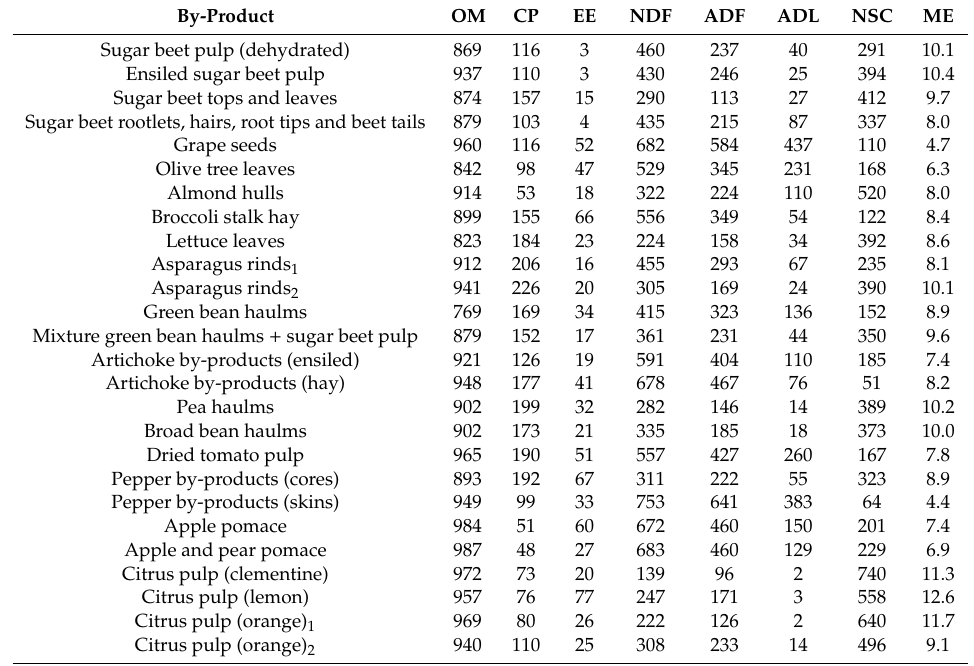
Table 2. Chemical composition (g / kg dry matter) and metabolizable energy concentration (MJ / kg dry matter) of